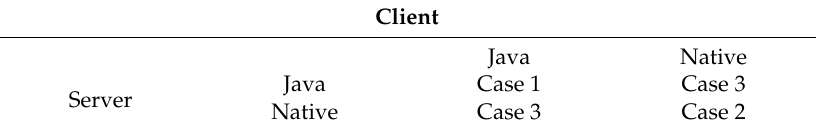
Table 1. The client/server combinations in information flows through Unix domain sockets.